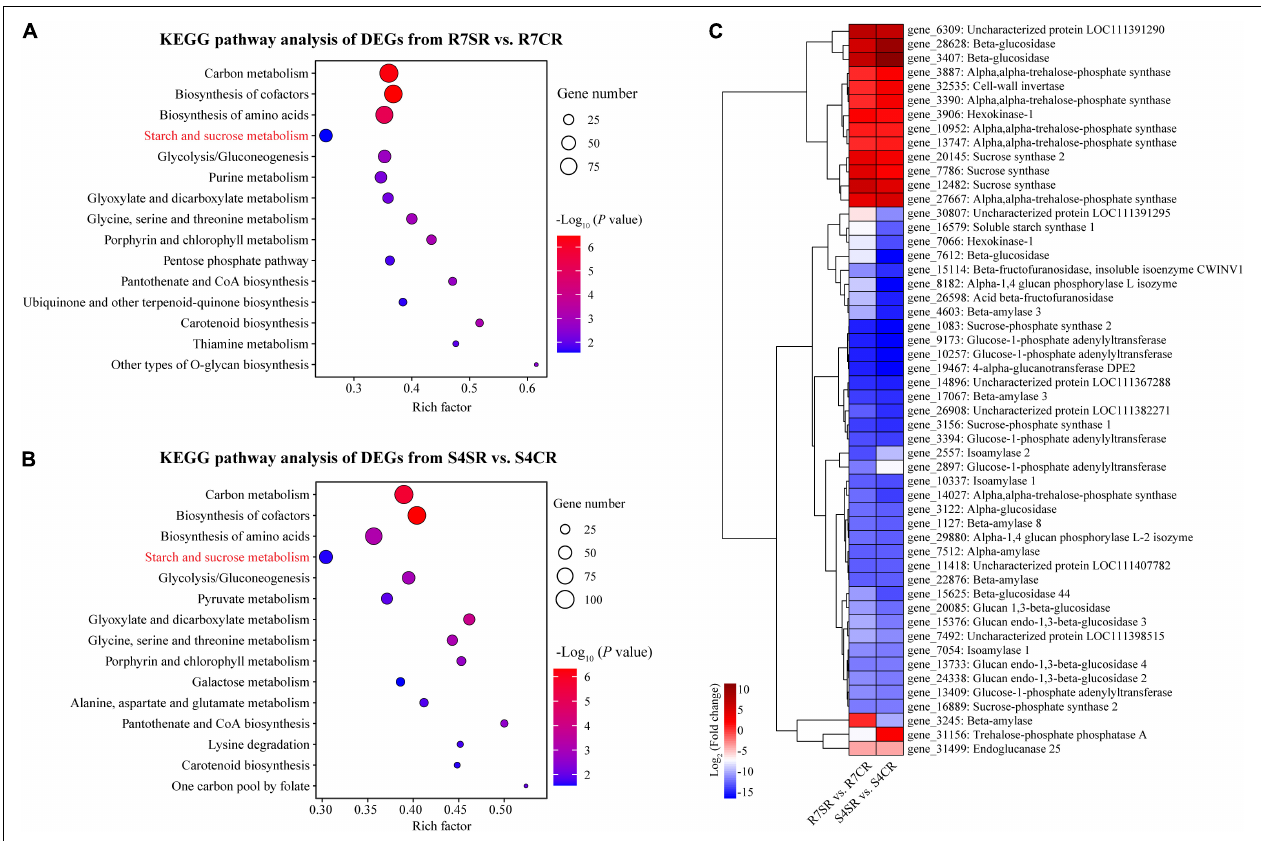
FIGURE 5 | Functional enrichment analysis of the DEGs and measuring soluble sugar contents in F. velutina R7 and S4 roots. (A,B) The top 15 enriched KEGG pathways (ranked by P -value) for DEGs in response to salt stress in tolerant (A) and sensitive roots (B) were showed. (C) The expression patterns of DEGs associated with “starch and sucrose metabolism” pathway in R7 and S4 roots underlying salt conditions. Heatmap colors represented the fold change and from blue to red represented the value from low to